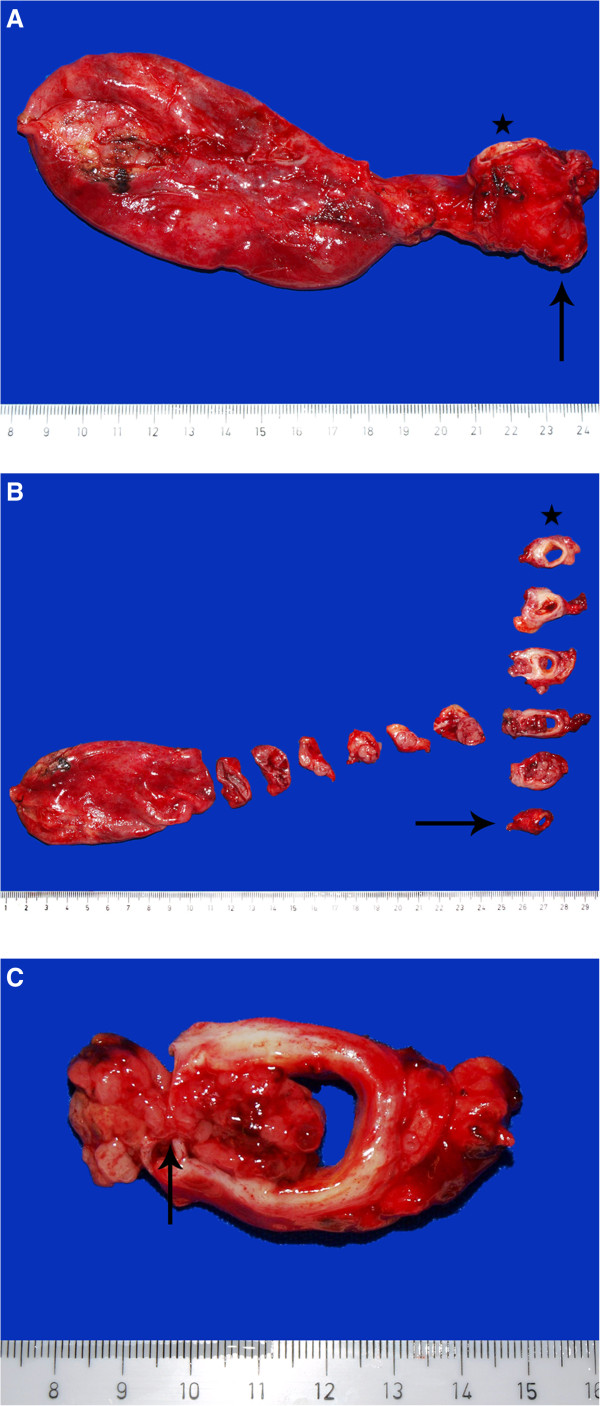
Gross findings of the resected pyloric gland adenoma. The resected specimen comprised the common bile duct (star), the bifurcation into common hepatic duct (arrow) and cystic duct with attached gallbladder (A). Cross sections revealed an intraluminal tumour of 2.5 cm length and 2 cm in diameter developing in the cystic duct (B), and protruding into the common bile duct and common hepatic duct (C, arrow).